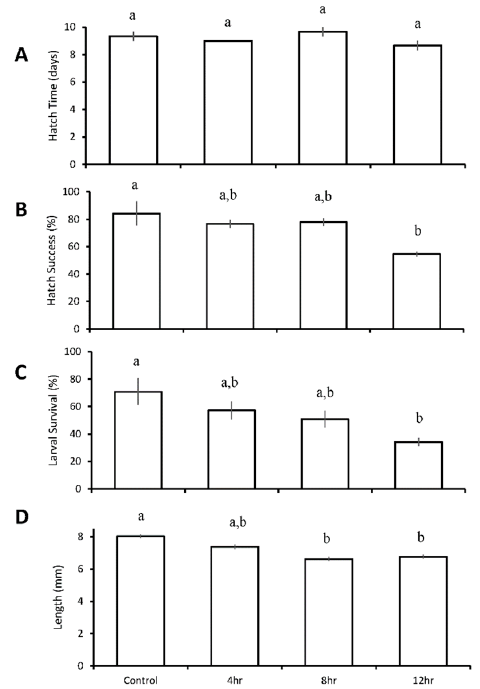
Figure 5. Hatch time ( A ), hatch success ( B ), survival ( C ), and length ( D ) of Menidia beryllina I larvae in the four treatment diurnal duration acidification and hypoxia experiment (Table 6 and Tables S17–S20) Bars represent the mean (n = 3) for each treatment. Error bars represent standard error of the mean (n = 3). Letters on bars represent significant differences among groups as determined by Tukey Honest Significance Difference tests.